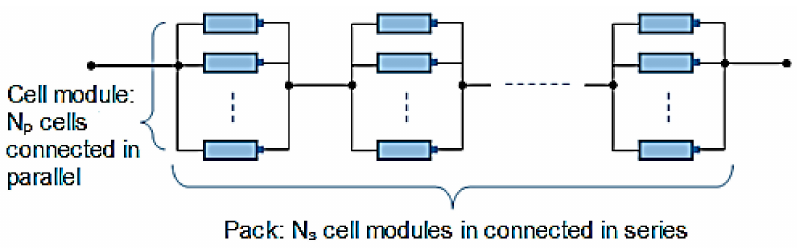
Figure 1. The pack of a lithium ion